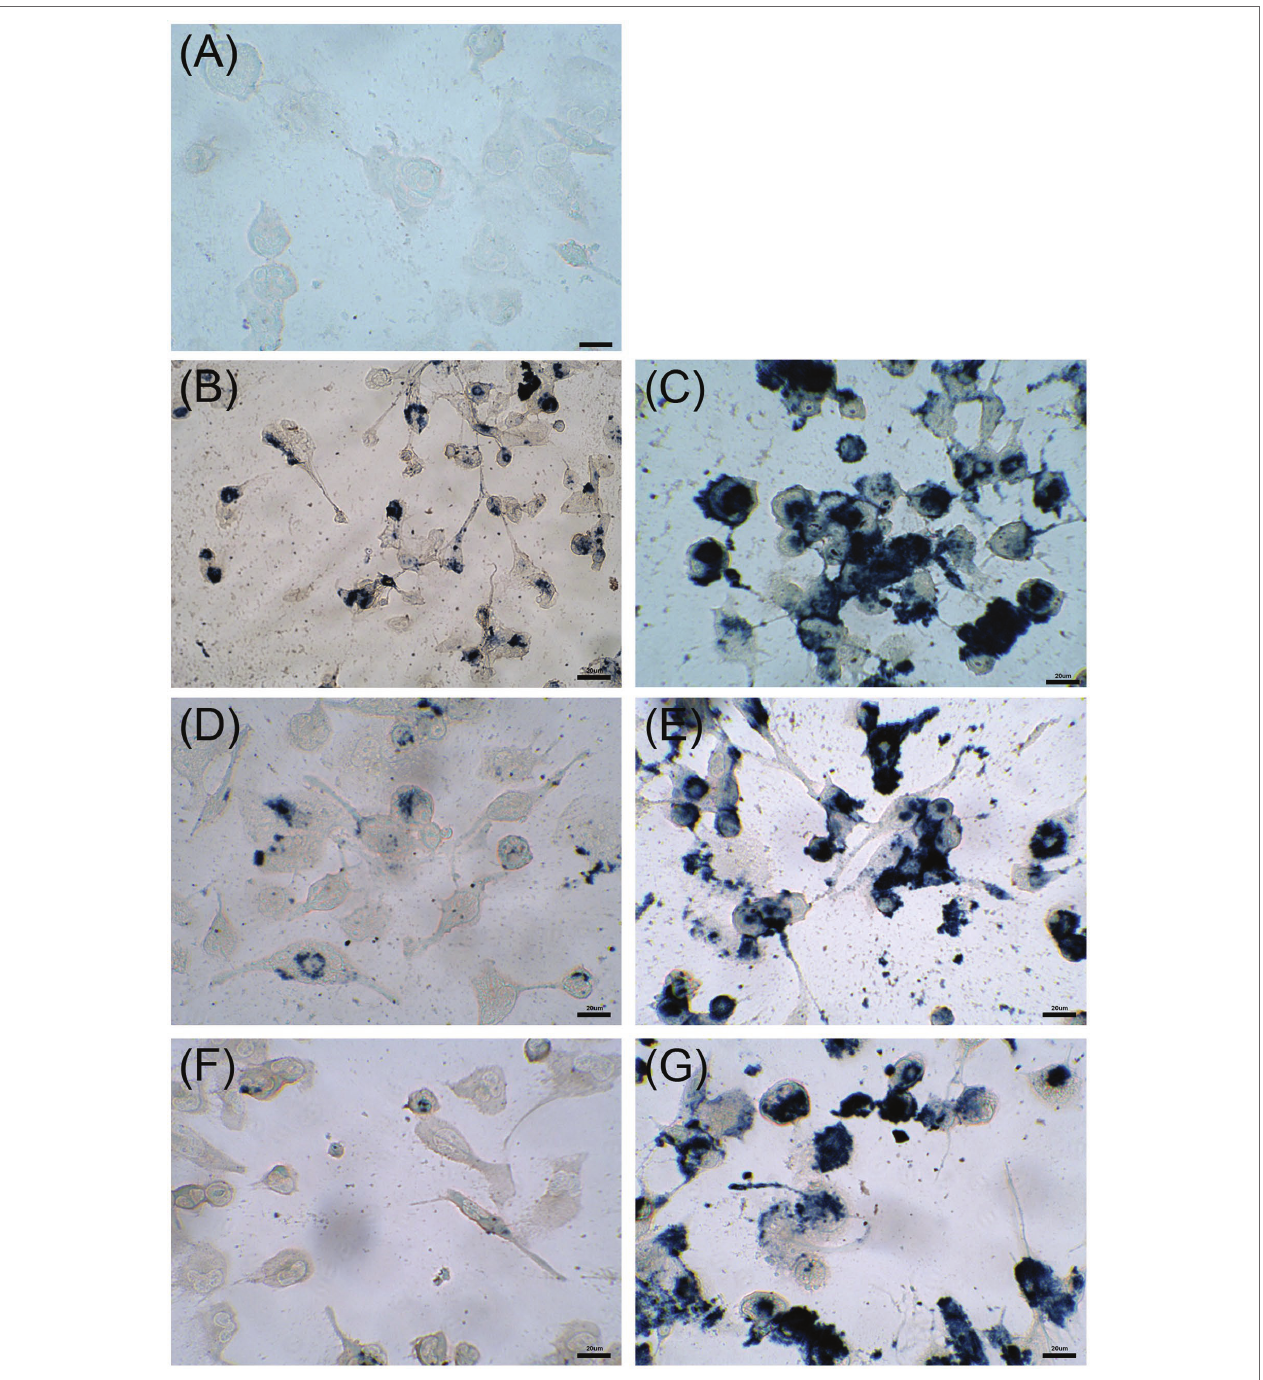
FIGURE 6 | Uptake by THP-1 cells after 24 h of incubation with 5 μ g/ml of IONPs (panel B ), 50 μ g/ml of IONPs (panel C ), 5 μ g/ml of NP-TEICO (panel D ), 50 μ g/ml of NP-TEICO (panel E ), 5 μ g/ml of NP-VANCO (panel F ), 50 μ g/ml of NP-VANCO (panel G ) and control untreated cells (panel A ). Prussian Blue staining of NP ferric ions was observed at the optical microscope; bars are 20 μ